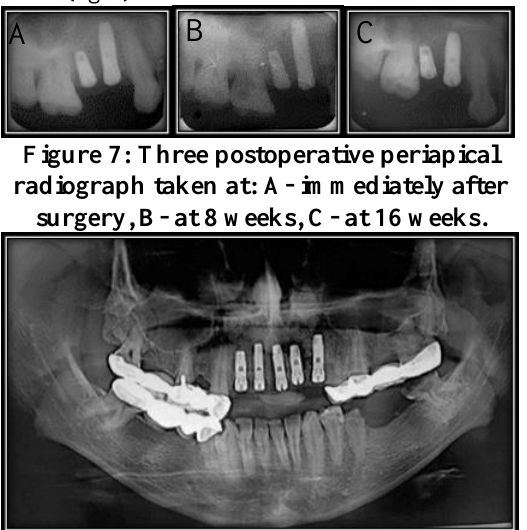
Figure 8: Postoperative OPG of the same patient in figure 1 taken at 16 weeks.